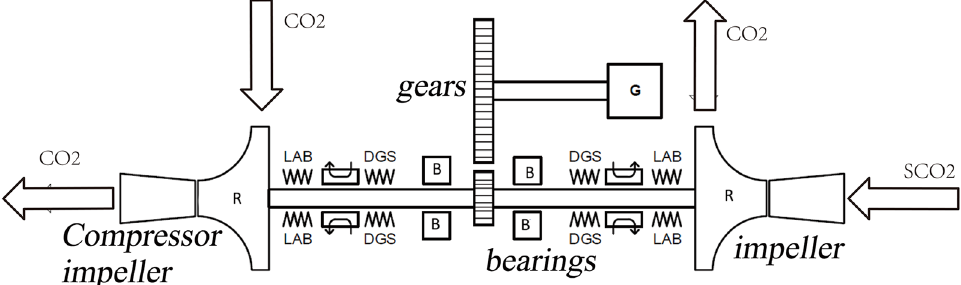
Fig. 1. Supercritical CO 2 radial-in- fl ow